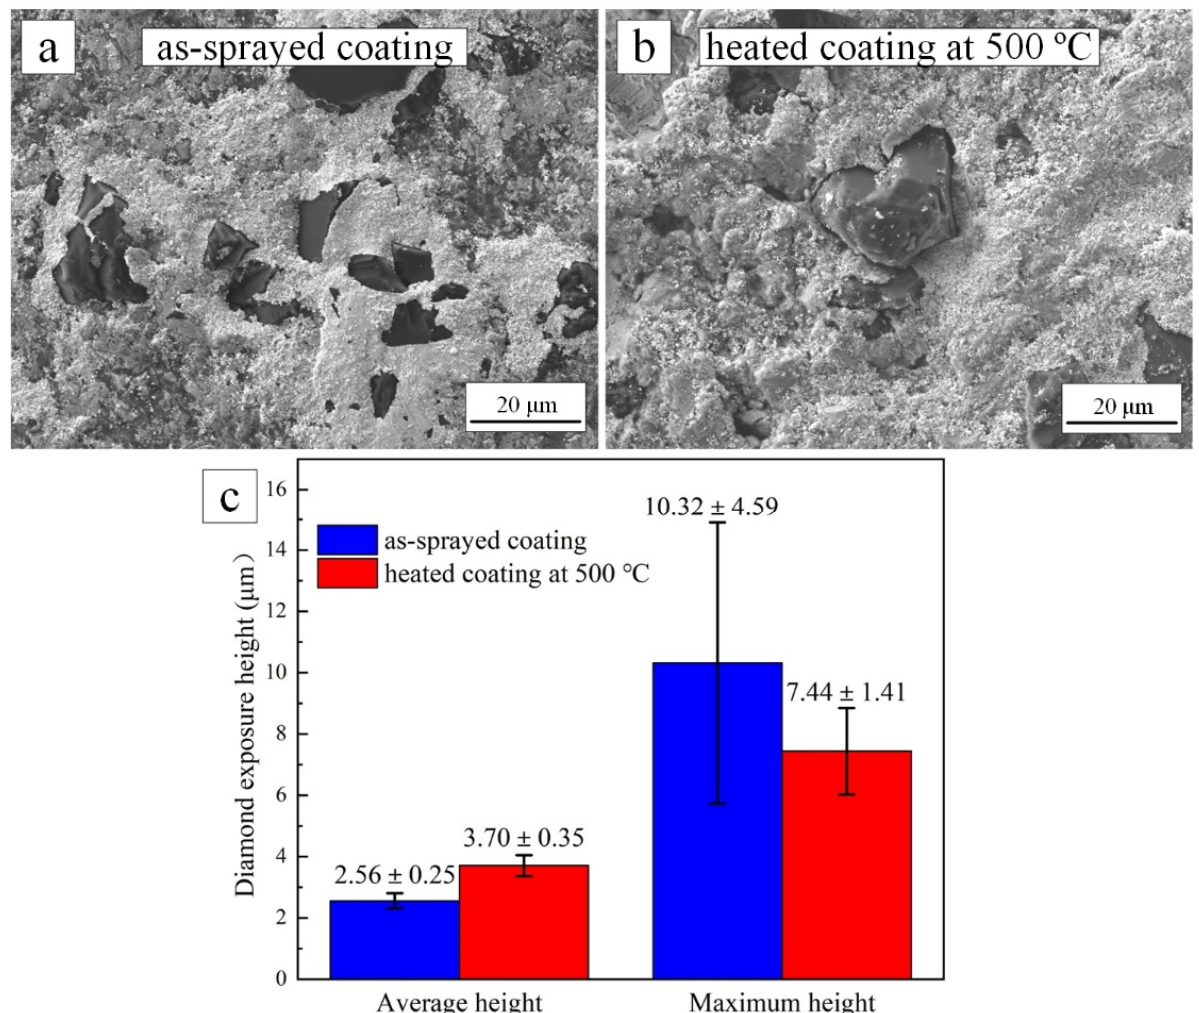
Figure 11. SEM images of the diamond particles in the wear track of as-sprayed coating ( a ) and 500 °C heat-treated coating ( b ) after ultrasonic cleaning; the exposure height of diamond particles measured by a 3D laser scanning microscope ( c ).